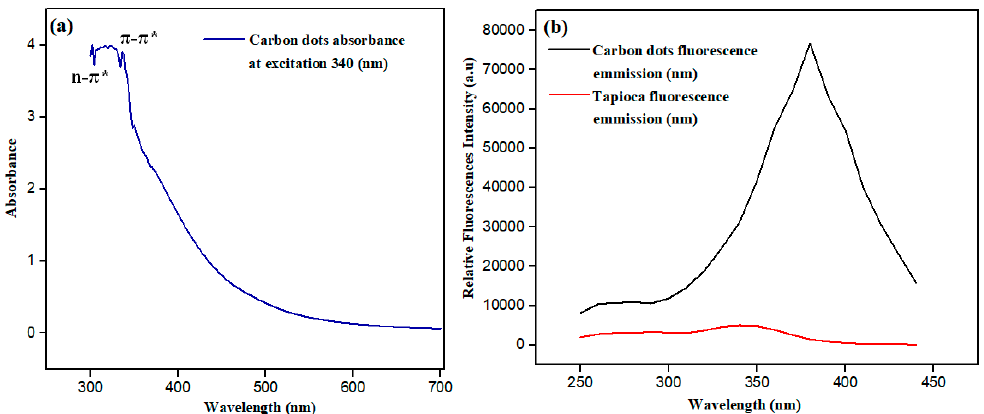
Figure 9. Optical properties of CDs. ( a ) UV-visible absorption and emission spectra of as prepared CDs dispersed in water. ( b ) Fluorescence emission spectra of carbon dots and reference material (Tapioca).